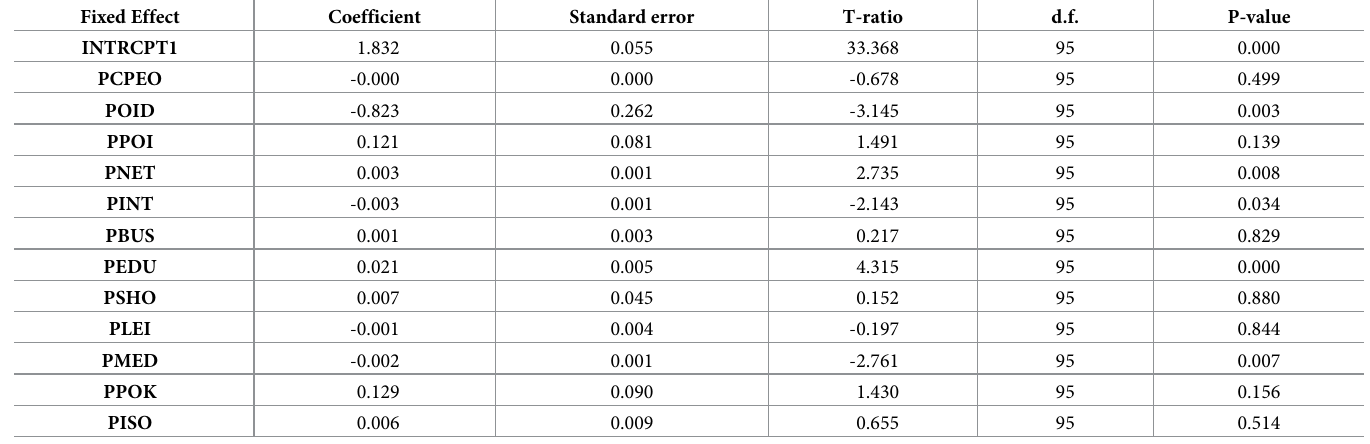
Table 4. The parameter estimation of the regression model based on the mean